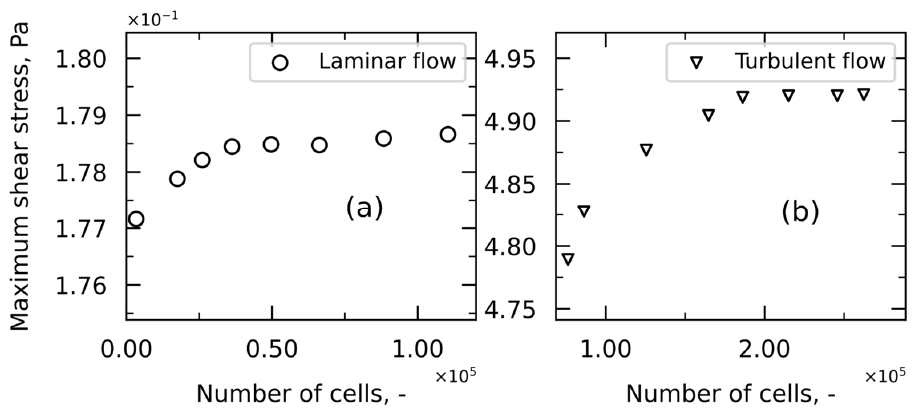
Figure 3. Grid independence analysis for the case of 9.53 mm diameter tubing under laminar ( a ) and turbulent ( b ) conditions.